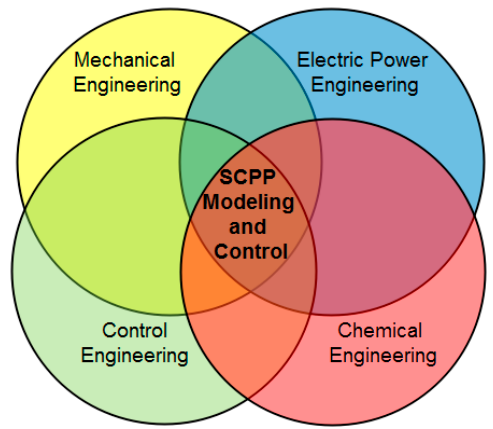
Figure 1. The interdisciplinary nature of supercritical power plant (SCPP) modeling and control